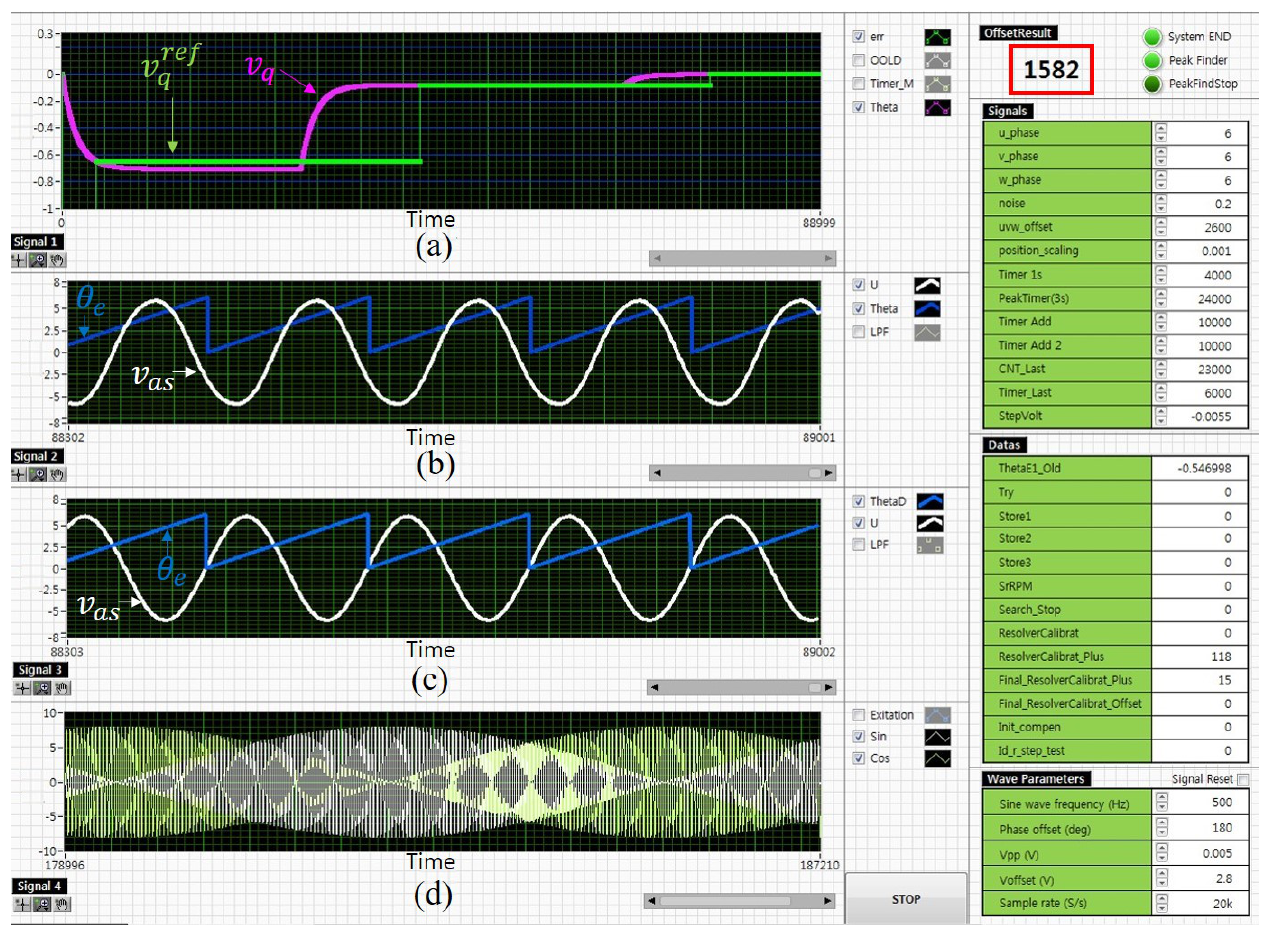
Figure 11. Graphic user interface of proposal method (ATO and axis transformation).